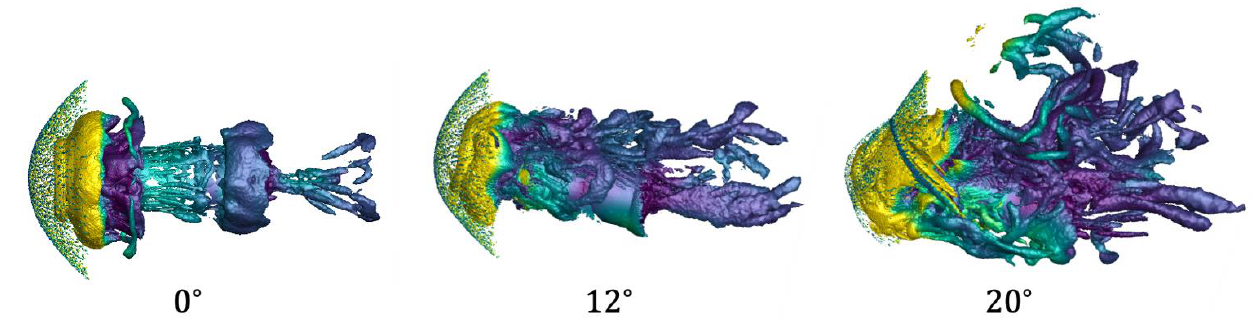
Figure 11. Q-criterion isosurfaces (15,000 per second) for the three angles of attack for BPANS CC ( 𝑓 𝑘 = 0.2) colored by pressure. Table 1. SRP geometrical flow features compared to experimental data [4].